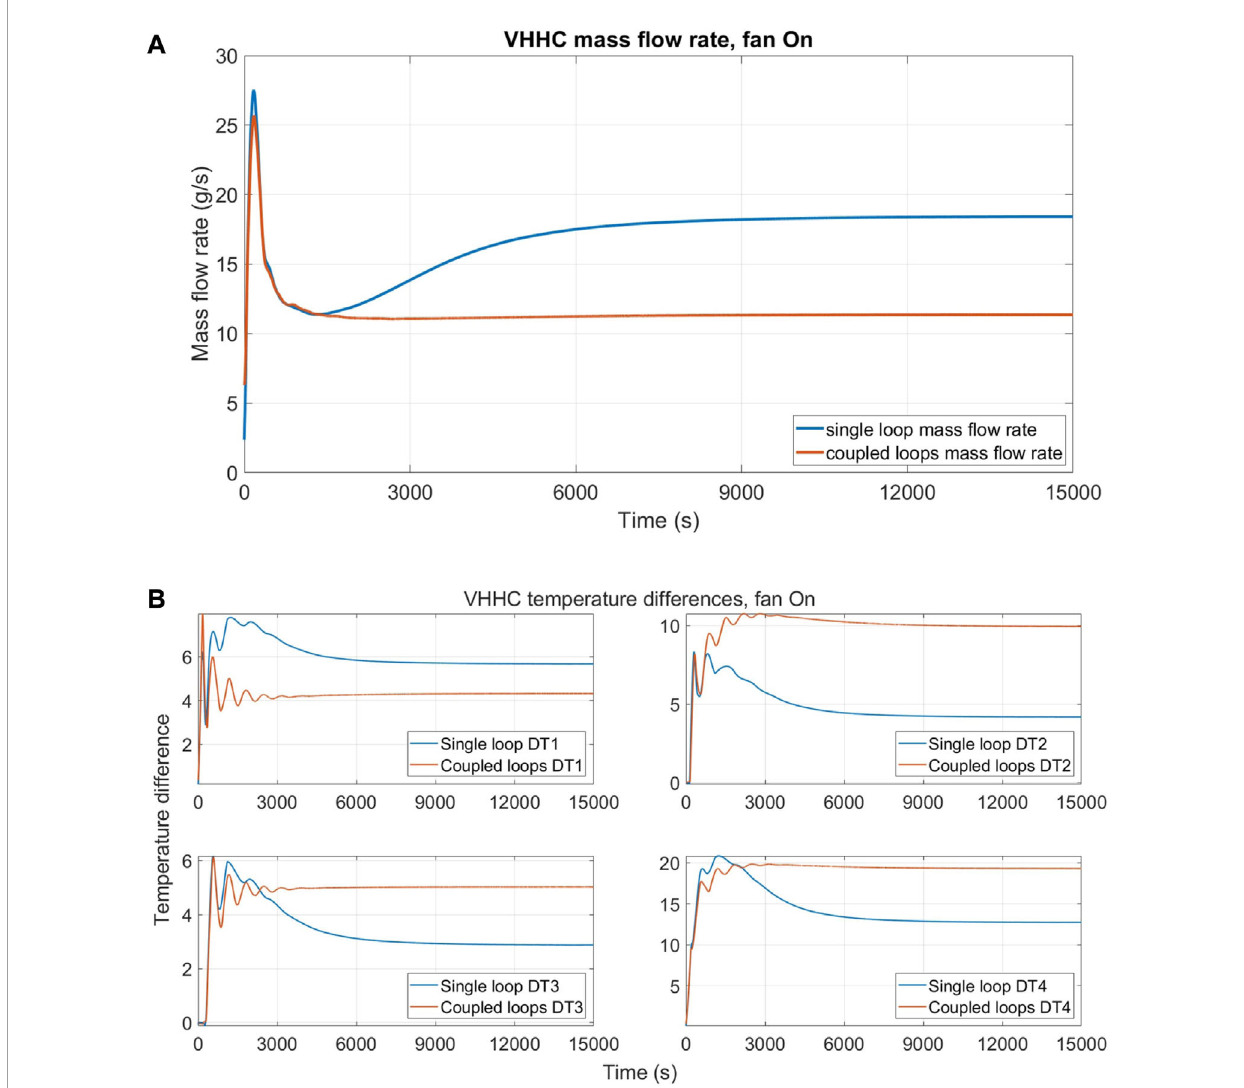
FIGURE 13 Comparison between single DYNASTY and coupled loop simulations with 25% fan speed for VHHC configuration; (A) mass flow rate evolution and (B) temperature difference evolution.